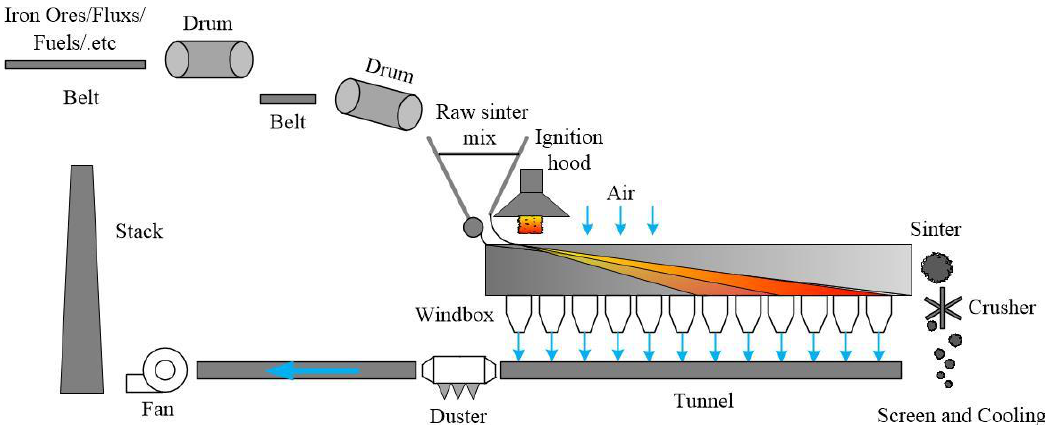
Figure 1. The sintering process.